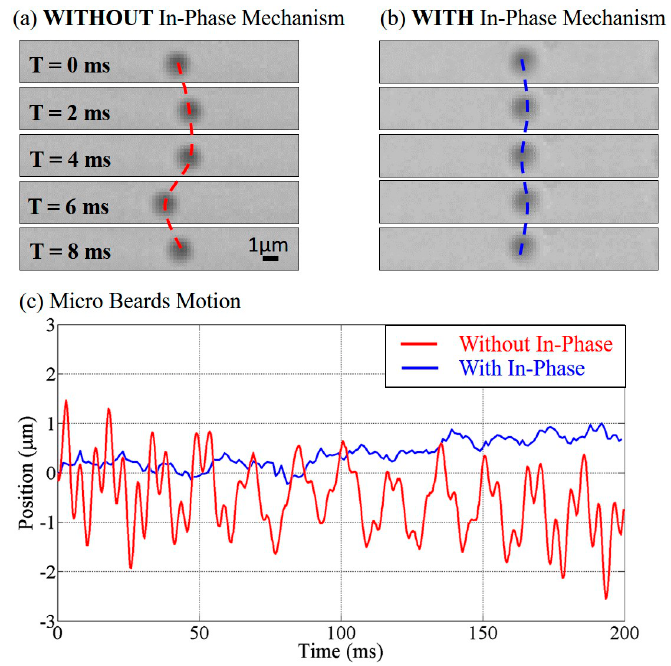
Figure 4. The motion of a microbead. ( a ) A microbead motion in the system without in-phase noise cancelation; ( b ) A microbead motion in the system with in-phase noise cancelation; ( c ) The tracked microbeads positions with respect to time.